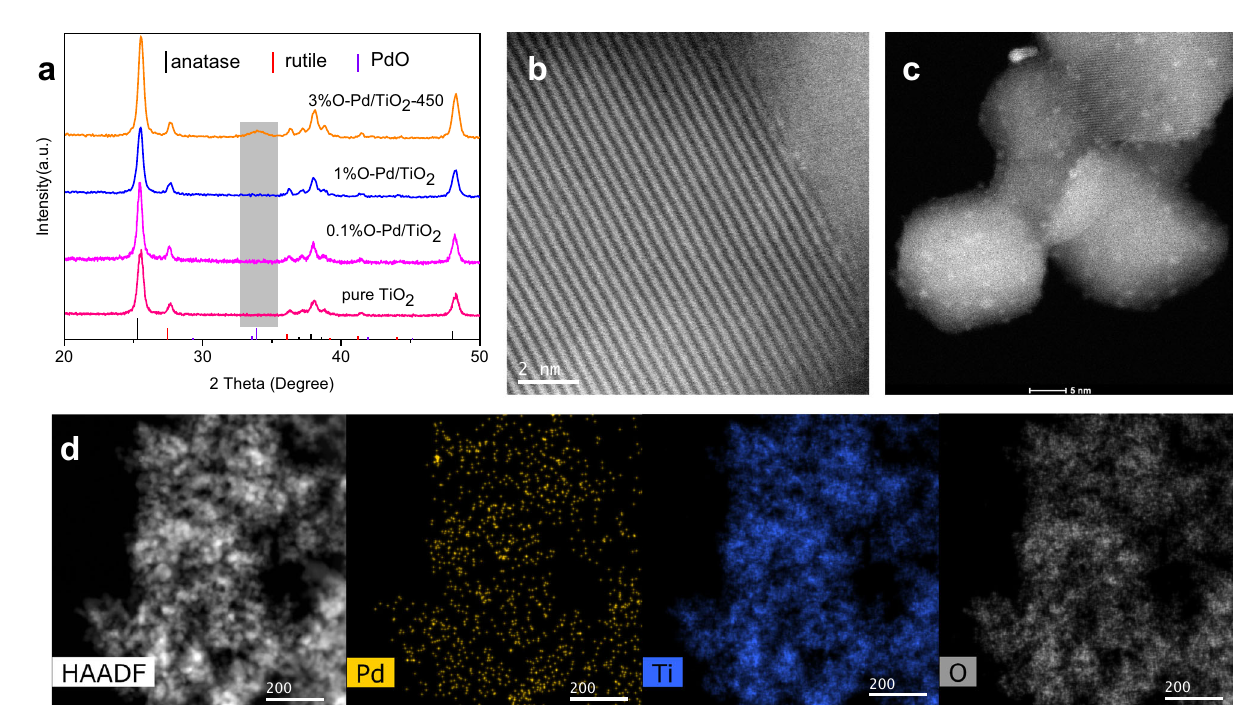
Fig. 2 | Structure characterization ofthe catalysts.a XRD patterns of O-Pd/TiO 2 . b HAADF-STEM images of 0.1%O-Pd/TiO 2 with 2nm scale bars. c HAADF-STEM